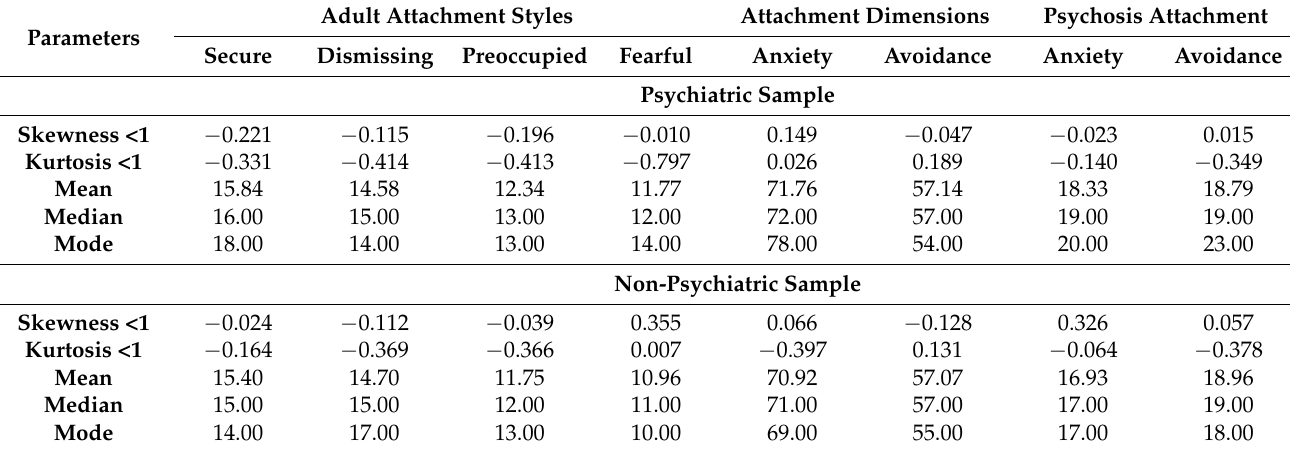
Table 2. Skewness, Kurtosis, and Descriptive Statistics of Attachment